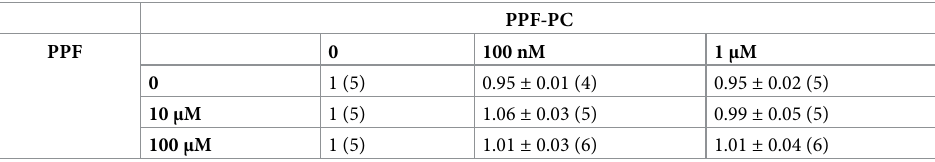
Table 2. Height Ratios (HR) of neurons exposed to PPF (N) = number of